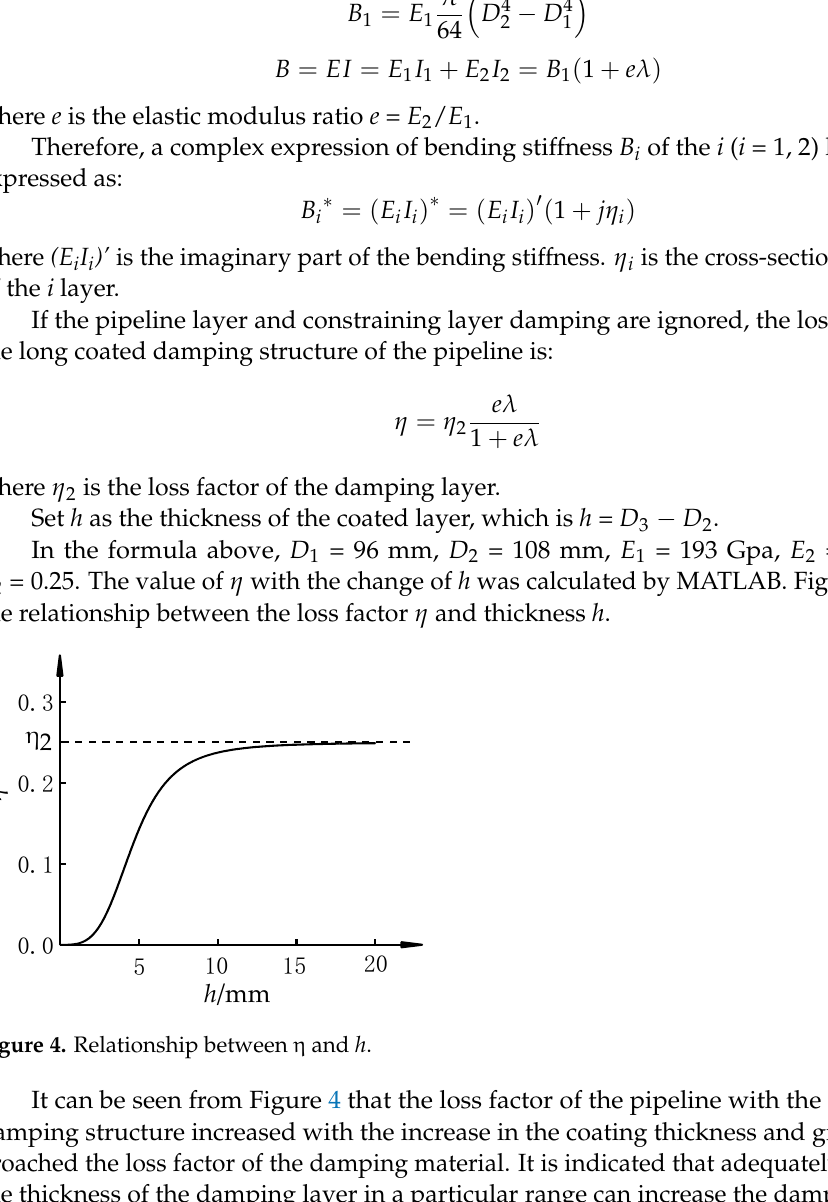
Figure 5. Plate-like entangled metallic wire material specimen.